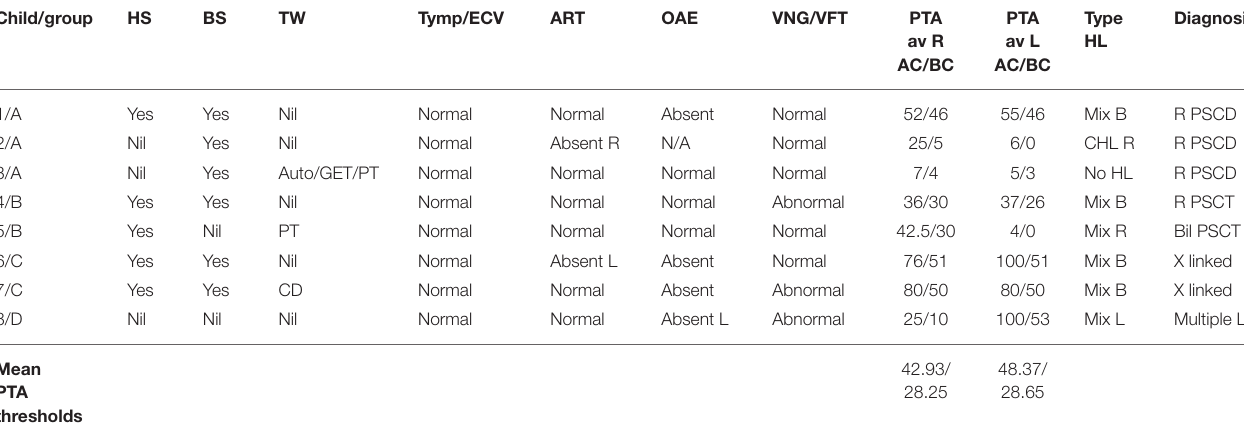
TABLE 4 | Children in case group.